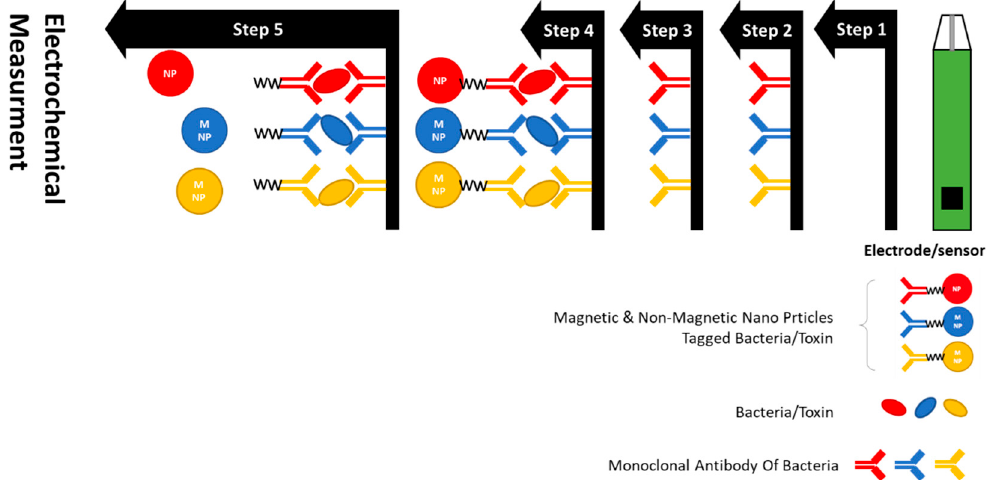
Figure 3. Schematics for bacteria and toxin detection using antibody based electrochemical biosensor.